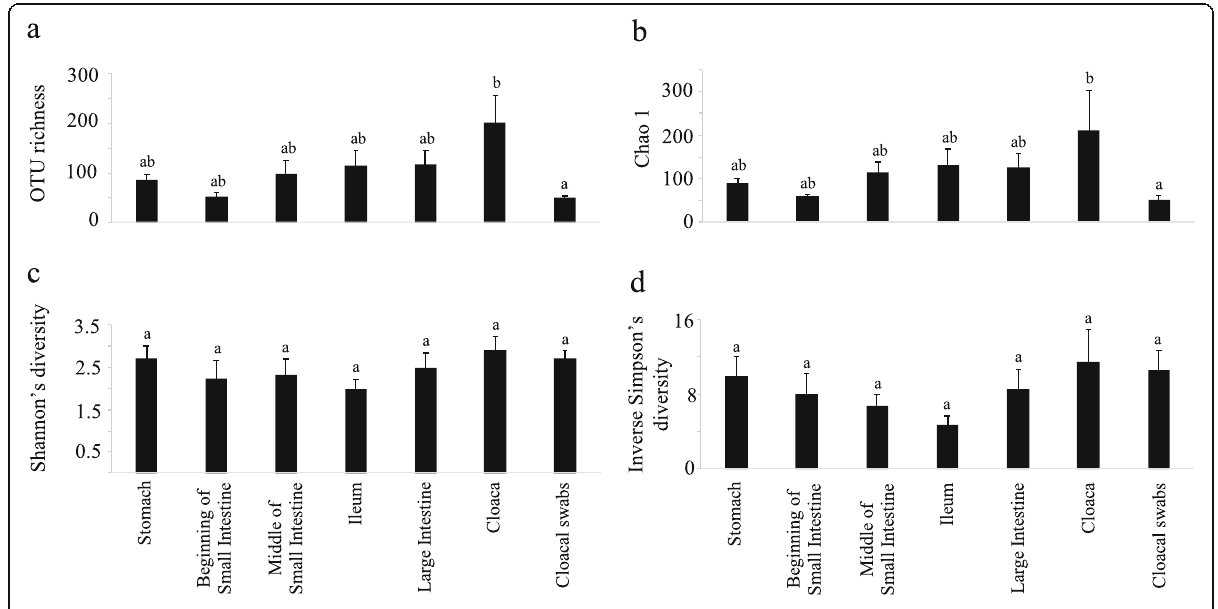
Fig. 1 Average ( a ) OTU richness, ( b ) Chao 1 richness estimates, ( c ) Shannon ’ s diversity index and ( d ) Inverse Simpson ’ s diversity index of different digestive tract regions and cloacal swab microbial communities. Letters on top of each bar represent the results from the Tukey post hoc test and similar letters represent non-significant swabs) [PERMANOVA (Jaccard): F = 1.44, 999permutations 6,54 R 2 = 0.1383, p = 0.001], the pairwiseAdonis showed that swabs differed significantly from the large intestine and the ilium (Additional file 2: Table S3).